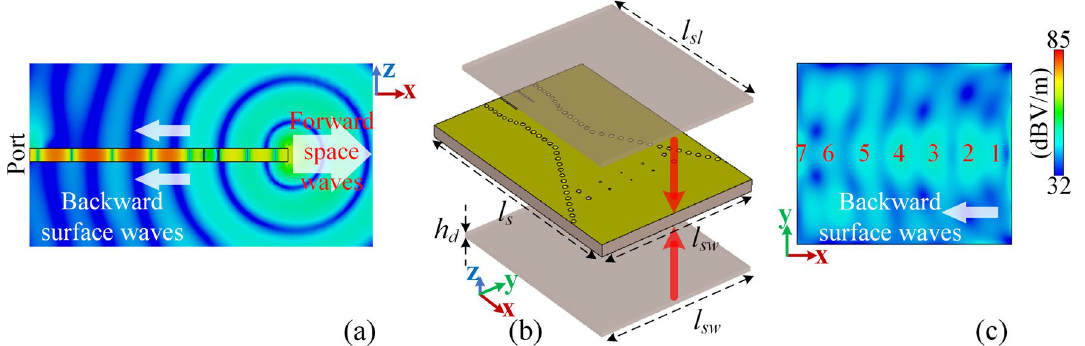
Figure 10. ( a ) The |E-filed| distribution pattern on a cut at xz plane crossing the middle of the phase-corrected structure, ( b ) the modified structure with two dielectric slabs of Rogers RT/duroid 6010 attaching to both sides, ( c ) the simulated |E-field| on the slab when it is mounted on the SIW horn. The simulation frequency is 30